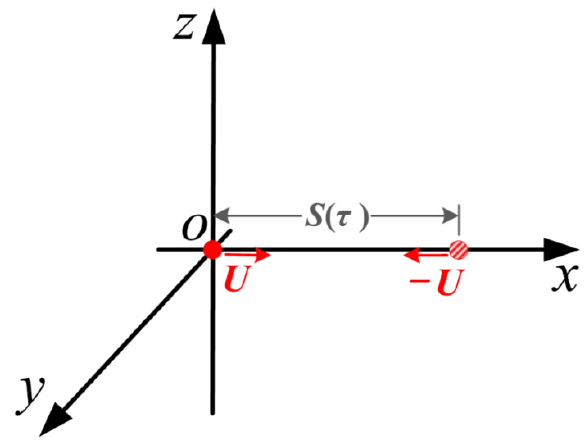
Figure 2. Schematic diagram of moving heat source in an infinite medium.